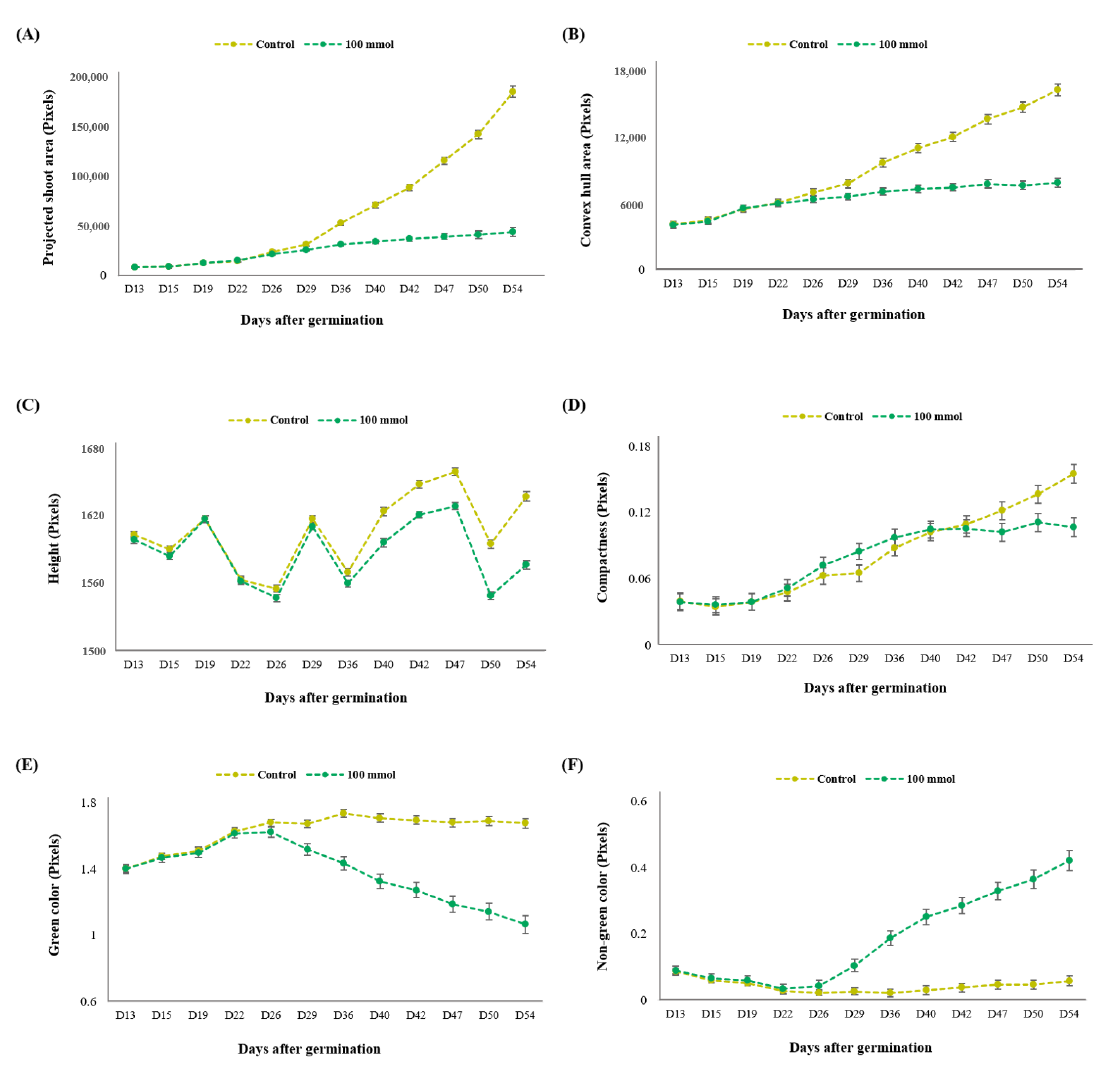
Figure 5 Figure 5. The variation in non-destructive phenotypic traits over time: ( A ) projected shoot area, ( B ) convex hull area, ( C ) height, ( D ) compactness, ( E ) green color, and ( F ) non-green